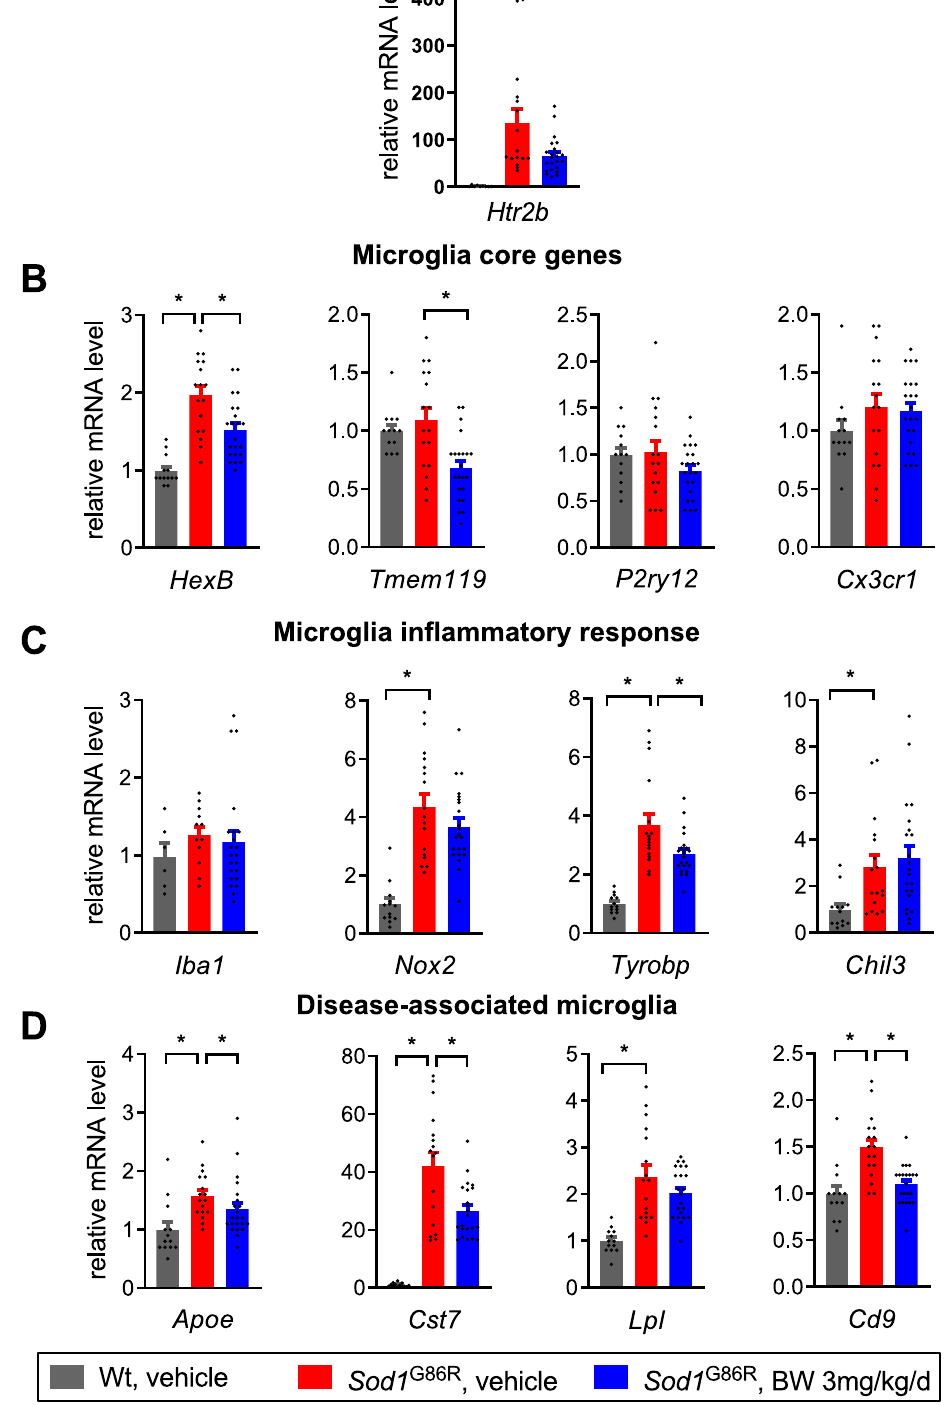
Figure 4. BW treatment modulates inflammation markers expression in spinal cord. ( A ) Expression of 5-HT 2B receptor, by RT-qPCR. ( B ) Expression of microglial marker of homeostasis and integrity. ( C ) Expression of microglial markers associated with inflammatory response. ( D ) Expression of microglial markers associated with DAM induction. All graphs presented as mean +/− SEM relative to the level of the wild-type control group. One-way ANOVA followed by Dunnett’s multiple comparison test. * p <